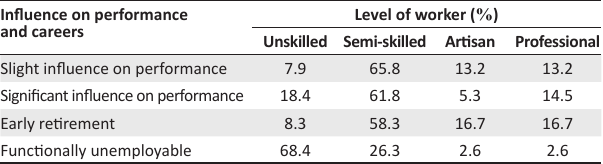
TABLE 2a: The cross tabulation of level of functioning of workers when accidents occur and their influence on performance and careers. Influence on performance and